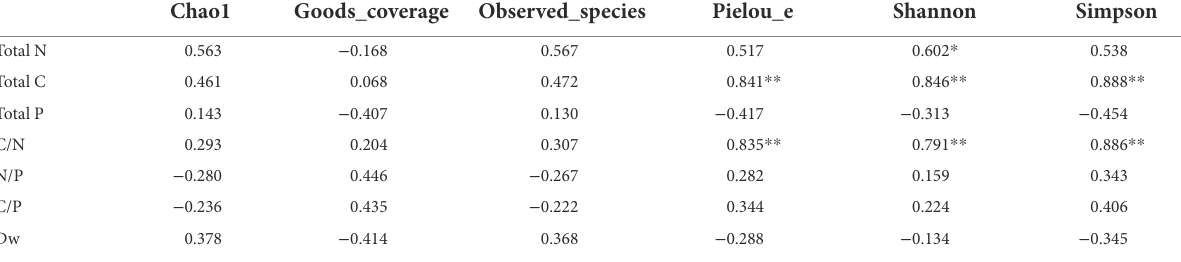
TABLE 3 Correlation between litter physicochemical properties and fungal community